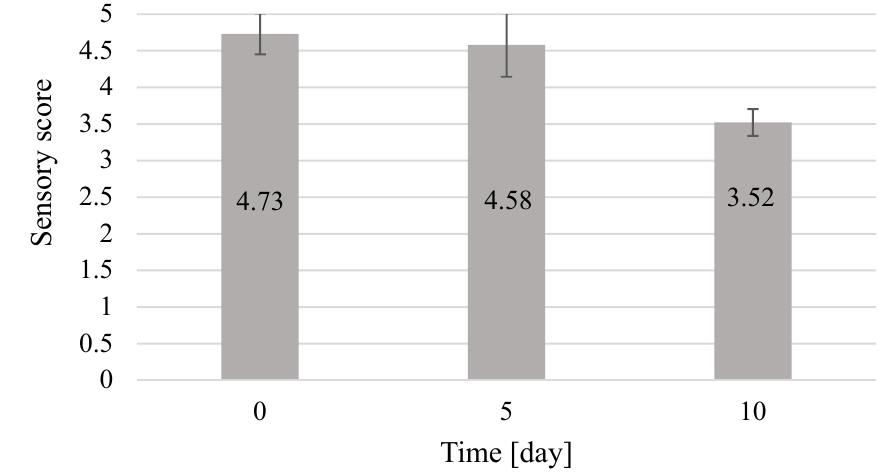
Figure 8. Overall result of the sensory analysis of beebread caviar.